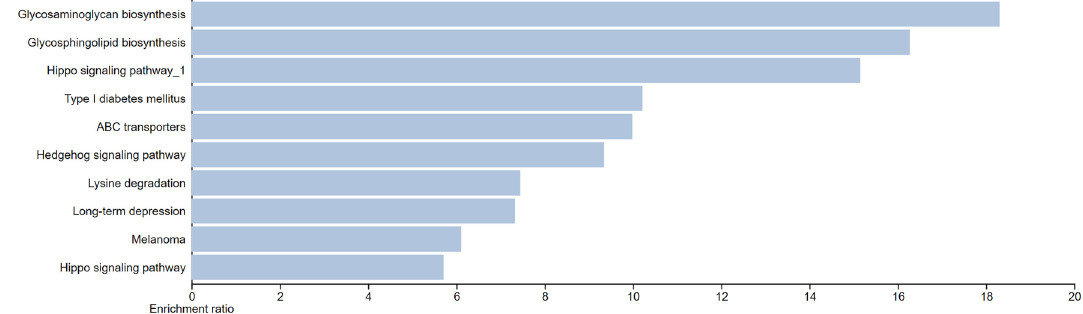
Figure 2. KEGG pathways identified as enriched by genes that are differentially methylated in T1D versus healthy individuals in our study. All the identified functional biological processes and pathways were in light blue indicating an FDR p-value of > 0.05.